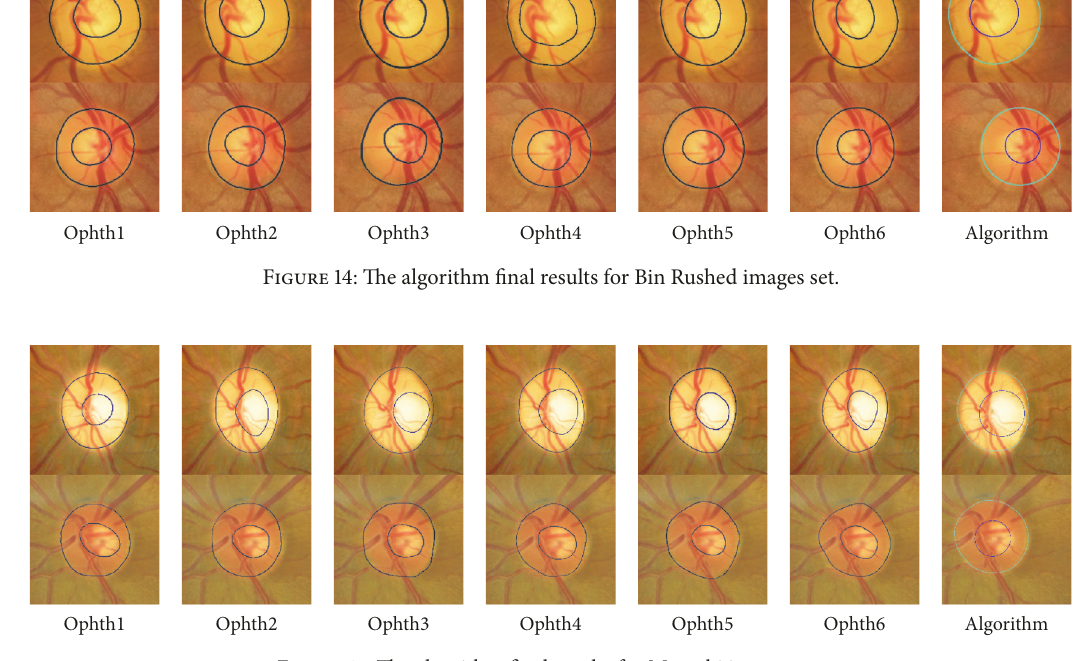
Figure 15: The algorithm final results for Magrabi images